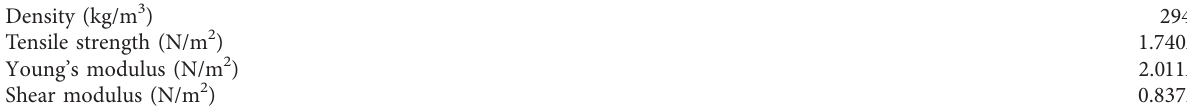
Table 1: Material properties of reinforced concrete [21].